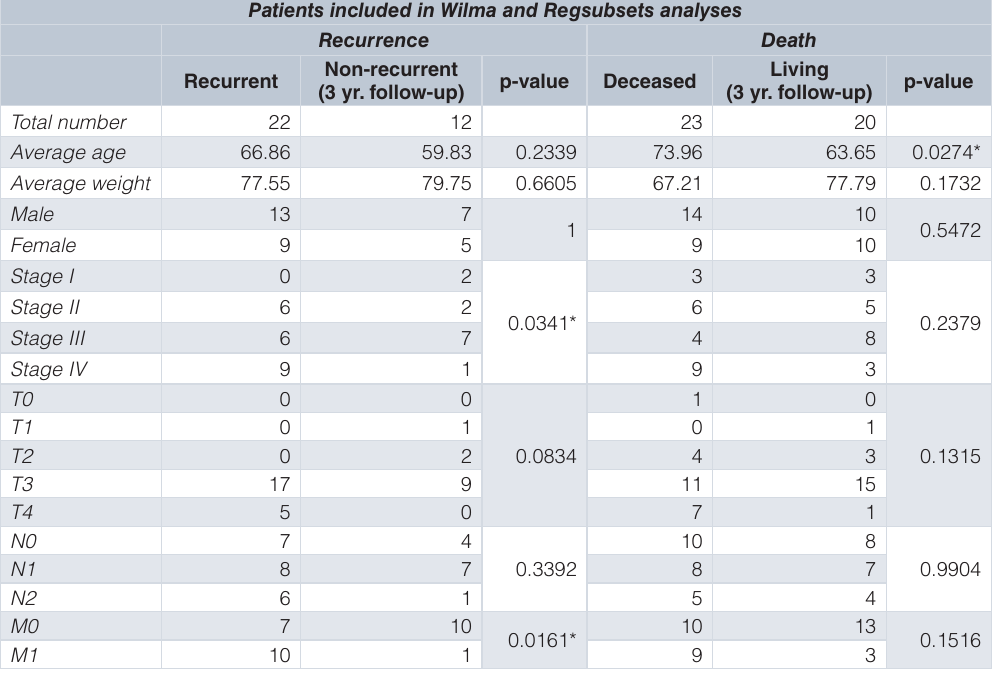
Table 1. Characteristics of patients with RPPA data included in Wilma and Regsubsets analyses for death and recurrence.